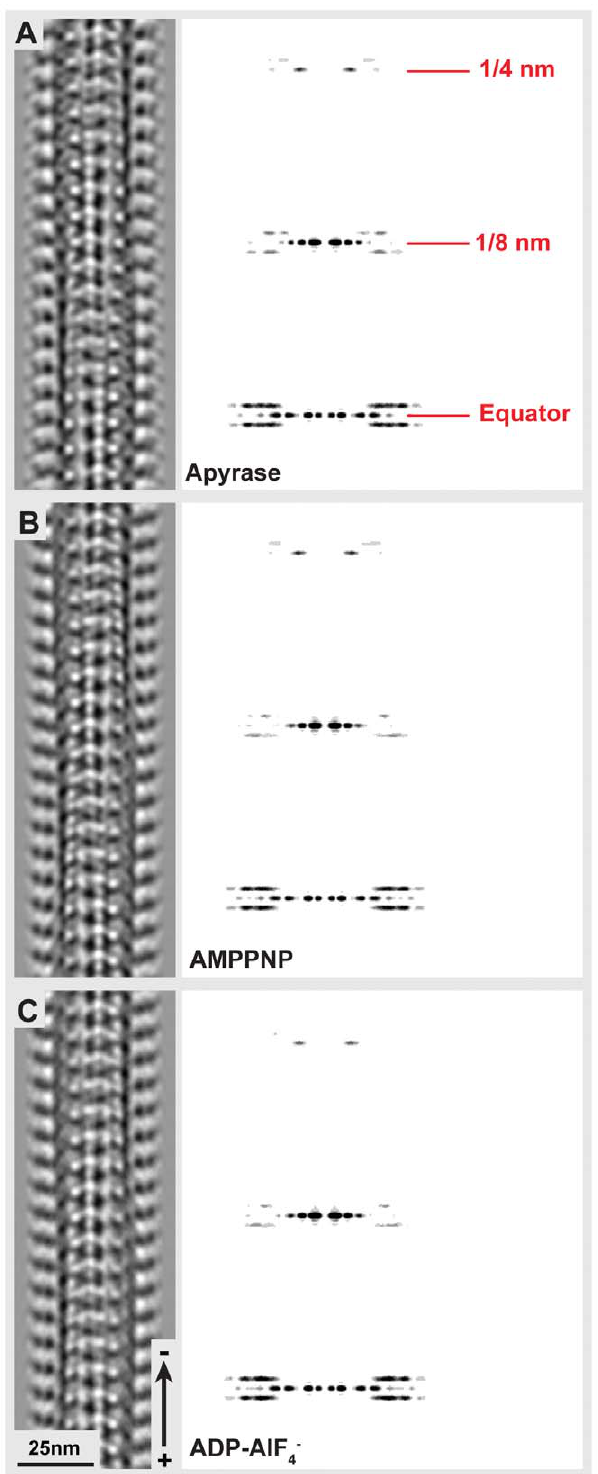
Figure 1. Kar3Vik1 binds to MTs in a cooperative manner. ( A ) High resolution heavy metal shadowing of Kar3MD monomers shows individual Kar3MDs binding to MTs in a stochastic (non-cooperative) manner. ( B ) Conversely, Kar3Vik1 binds to MTs in a cooperative fashion, which is demonstrated by one MT being completely decorated by Kar3Vik1 (right), while an adjacent MT is completely free of motor decoration (left). ( C ) A single MT showing one protofilament that is